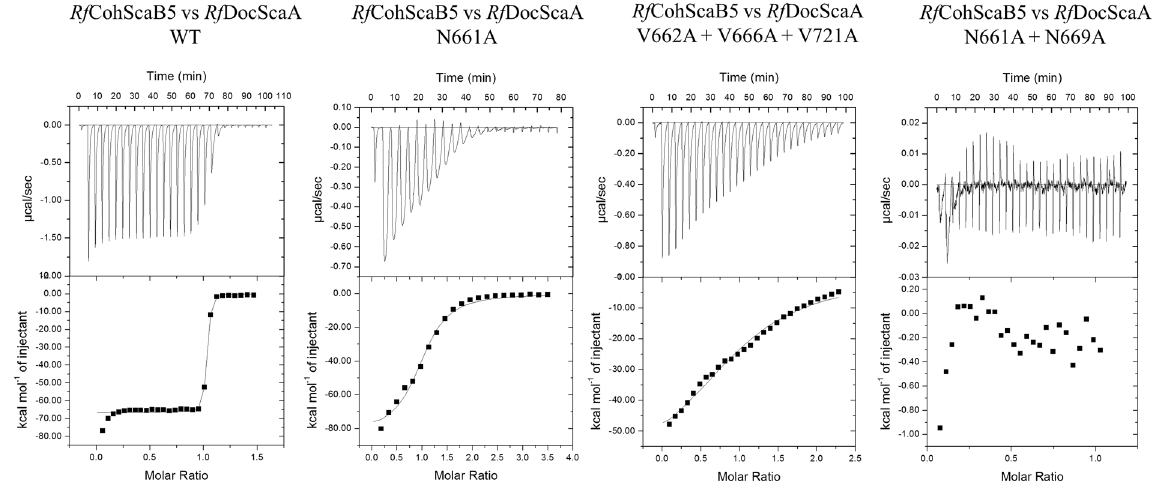
Figure 6. Binding affinity of CohScaB5 to DocScaA mutant derivatives and wild type partners as determined by ITC. Binding isotherms for: Panel A, Rf CohScaB5 vs Rf DocScaA; Panel B, Rf CohScaB5 vs Rf DocScaA N661A; Panel C, Rf CohScaB5 vs Rf DocScaA triple mutant; and Panel D, Rf CohScaB5 vs Rf DocScaA N661A + N669A double mutant. The upper part of each panel shows the raw heats of binding, whereas the lower parts comprise the integrated heats after correction for heat of dilution. The curve represents the best fit to a single-site binding model. The corresponding thermodynamic parameters are shown in Table 6.